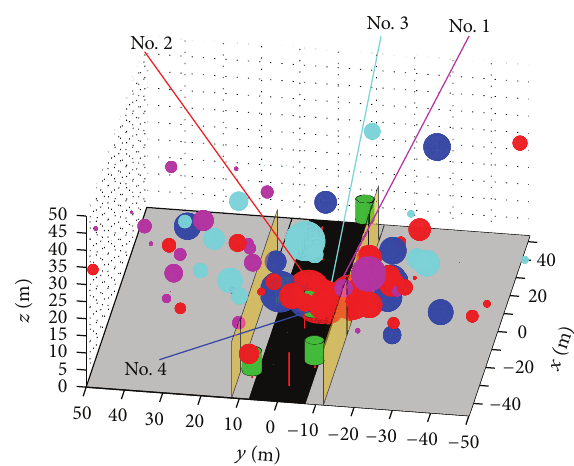
Figure 23: Visualization of the channel state within the artificial scenery. Example shows 4 different LOS paths visualized together with their echoes—respectively, the reflector locations where they originate from and their momentary powers (size of the spheres) — in the corresponding